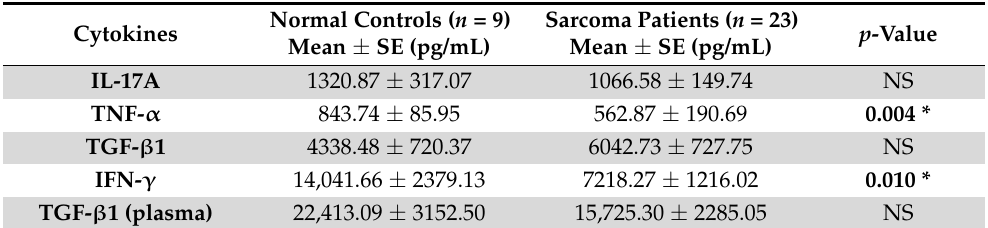
Table 3. Summary of Con A stimulated cytokines in culture supernatant and plasma cytokine concentration in sarcoma patients and normal controls. Normal Controls ( n = 9) Sarcoma Patients ( n = 23) Cytokines Mean ± SE (pg/mL) Mean ± SE (pg/mL)